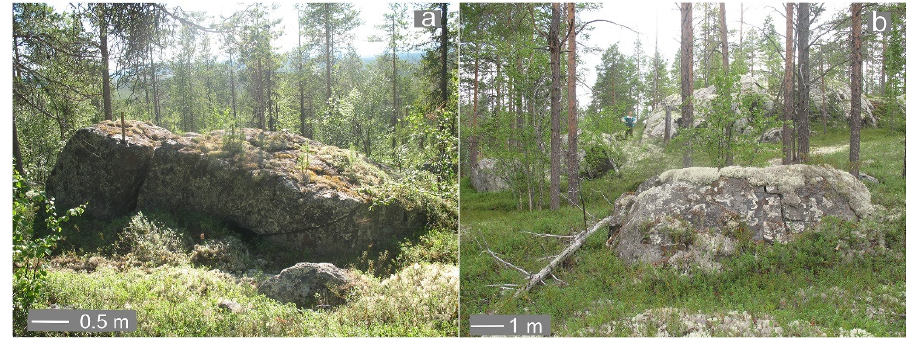
Figure 5. ( a , b ) Typical exposures of ultramafic rocks in the Lyavaraka complex. In the background of ( b ), S.S. Kramzaev stands near a large and sloping outcrop of pegmatitic Opx–Amp rocks.